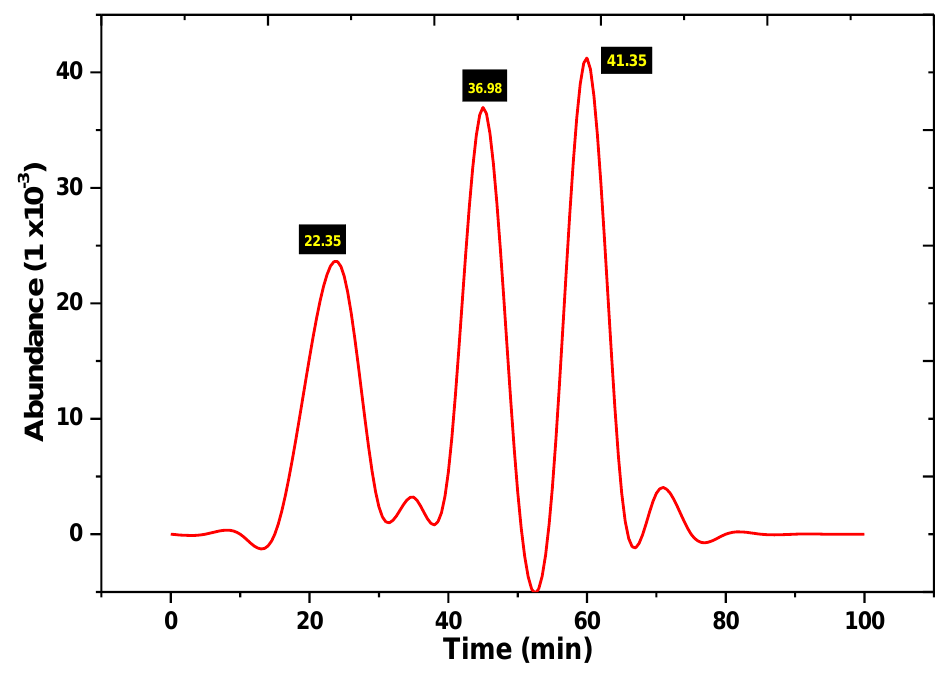
Figure 7. Chromatogram of the samples of neem leaves